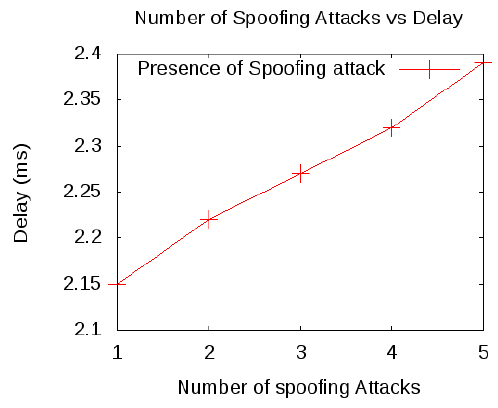
Figure 11. Delay in the presence of spoofing attack.